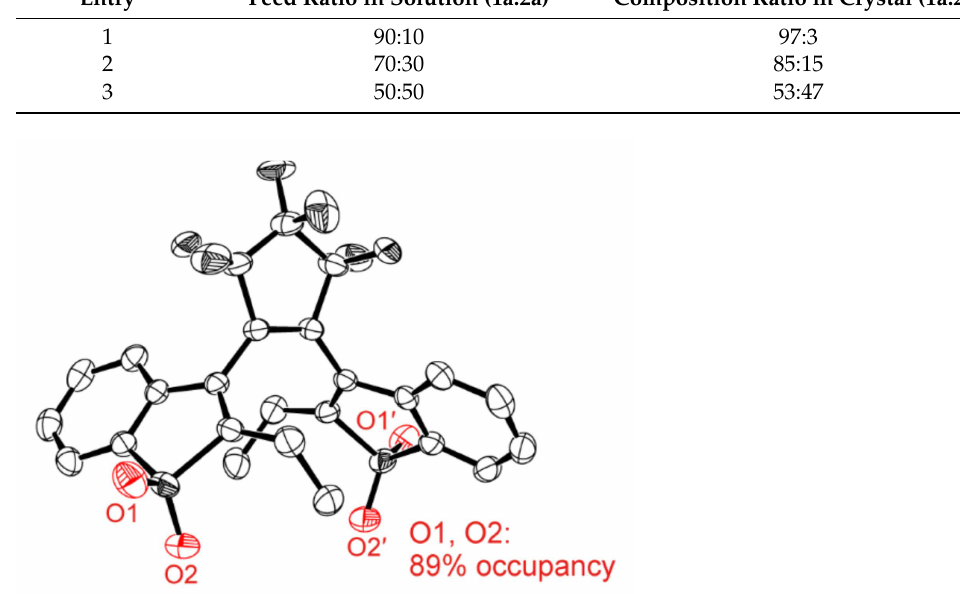
Figure 4. Molecular structure in a two-component mixed crystal containing 1a and 2a (entry 2 in Table 2) determined by X-ray crystallographic analysis. The crystal was prepared by recrystallization of a mixture of 1a and 2a with a molar ratio of 1a : 2a = 70:30 from acetone. The composition ratio of the crystal was 1a : 2a = 85:15 as determined by HPLC. According to the X-ray analysis, the occupancy parameter of the oxygen atoms (O1 and O2) was